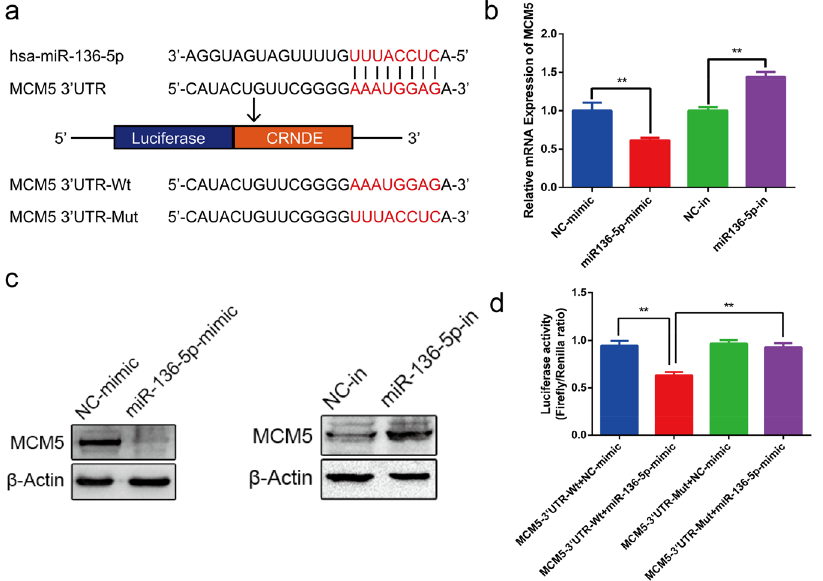
Figure 5. MiR-136-5p targets MCM5. ( a ) The binding sites between MCM5 and miR-136-5p were predicted by TargetScan 7.2 (http:// www. targe tscan. org/ vert_ 72/). ( b ) QRT-PCR assay was used to detect the expression of MCM5 mRNA after transfecting mimic or inhibitor. ( c ) The expression of MCM5 protein was detected by western blot. 9 d ) Luciferase reporter assay for analysis of the interaction between miR-136-5p and MCM5. * p < 0.05, ** p <